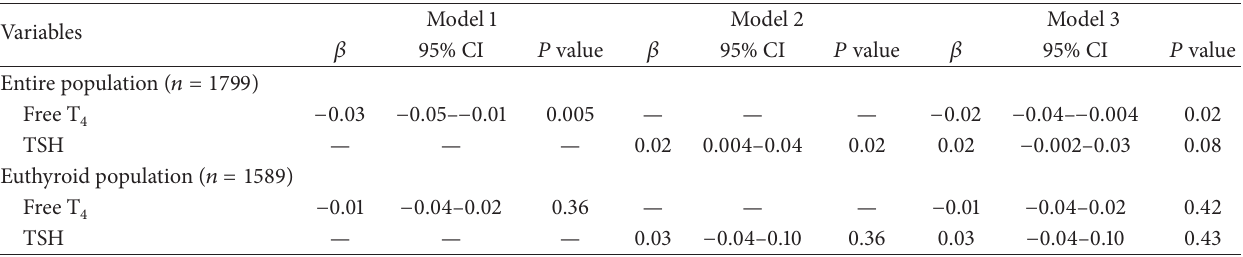
Table 5: Correlates of free T 4 and TSH to the severity of coronary